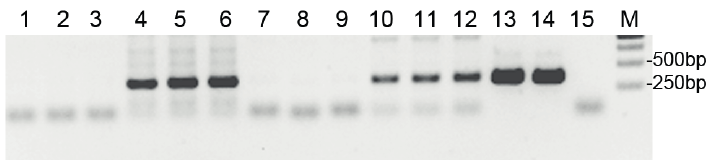
Fig. 2. Rcc -specific Primers Rc3 and Rc5 were used for amplification of 348 bp DNA fragment. Lanes: 1‒6 cv. Fridericus; 7─12 cv. Cinderella; 13‒14 positive control (100 pg of Rcc DNA); 15. negative control (SDW). Marker - M 1.0 kbp DNA ladder Plus (Thermo Scientific)